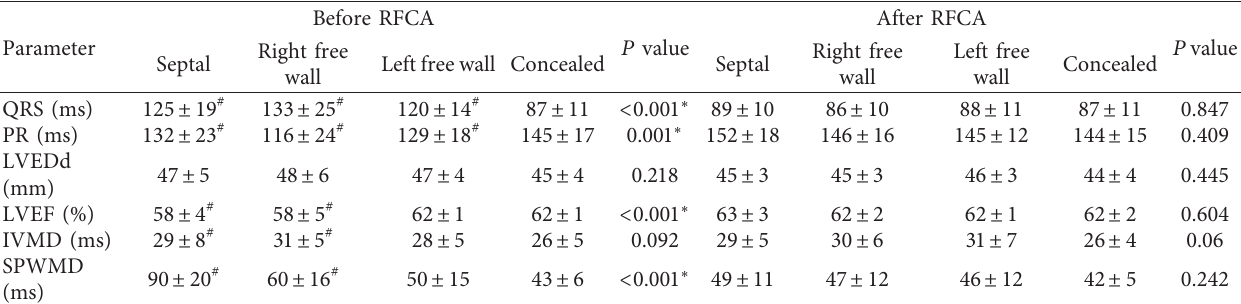
Table 2: Electrocardiographic and echocardiographic data before and after